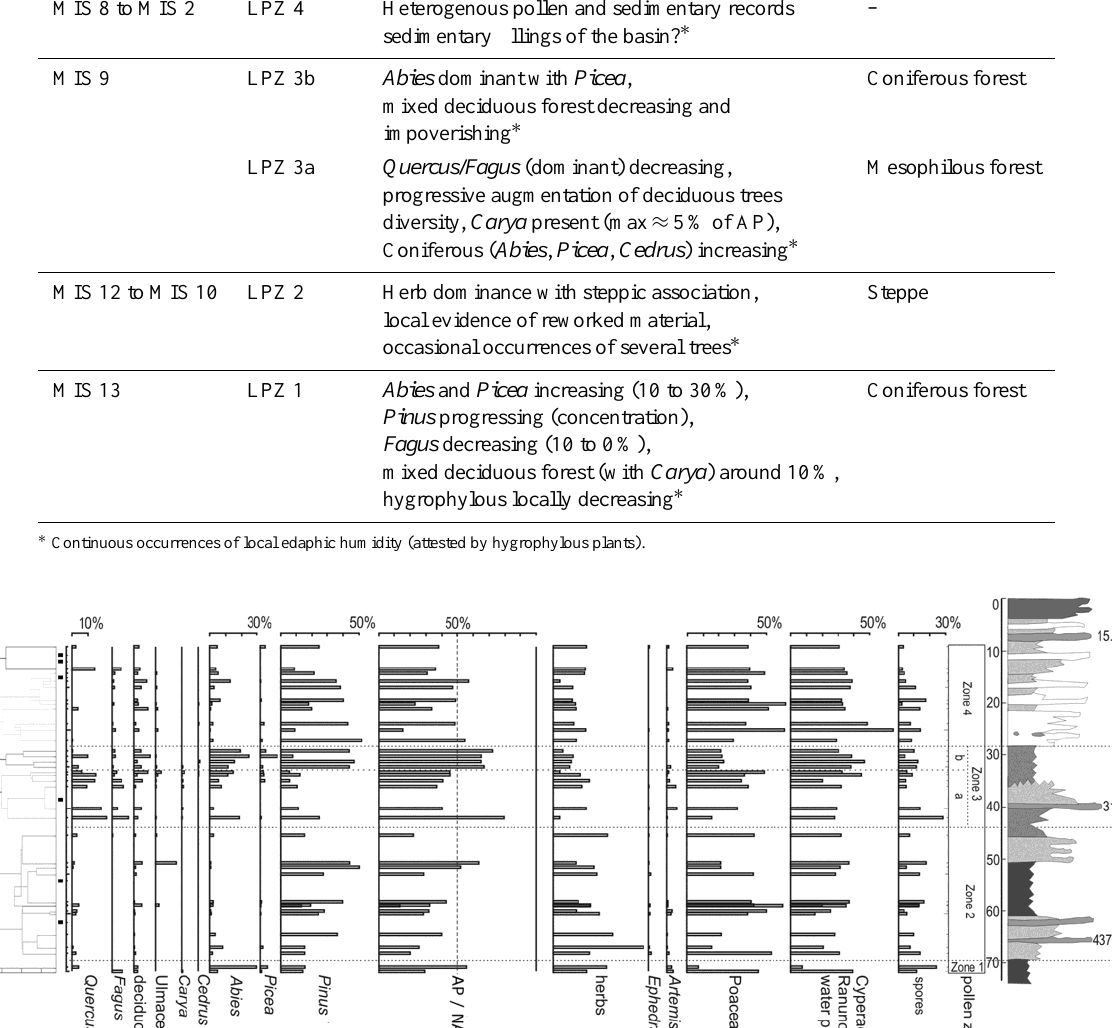
Figure 4. Synthesized diagram of the local palynological studies, presenting the dynamics of 7